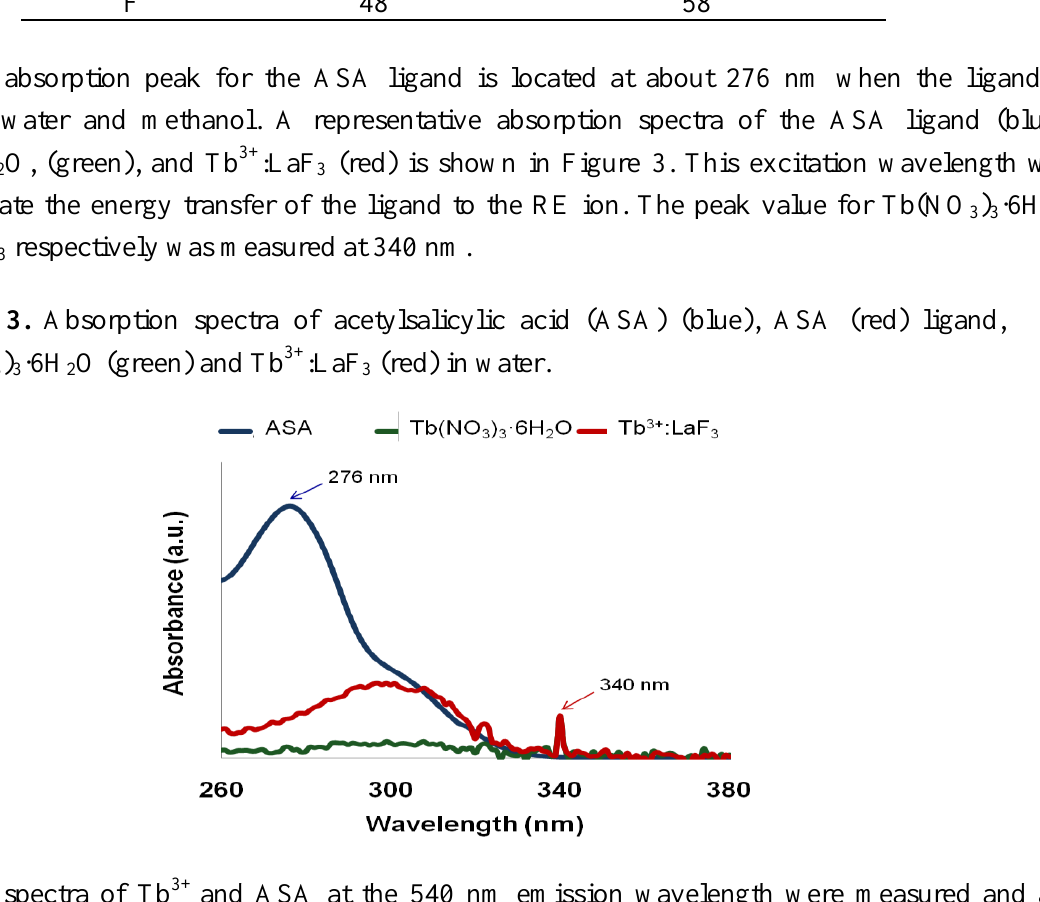
Table 1. Elemental composition and corresponding atomic percentage of nanoparticles in polymethyl methacrylate (PMMA) synthesized in different solvents. Element